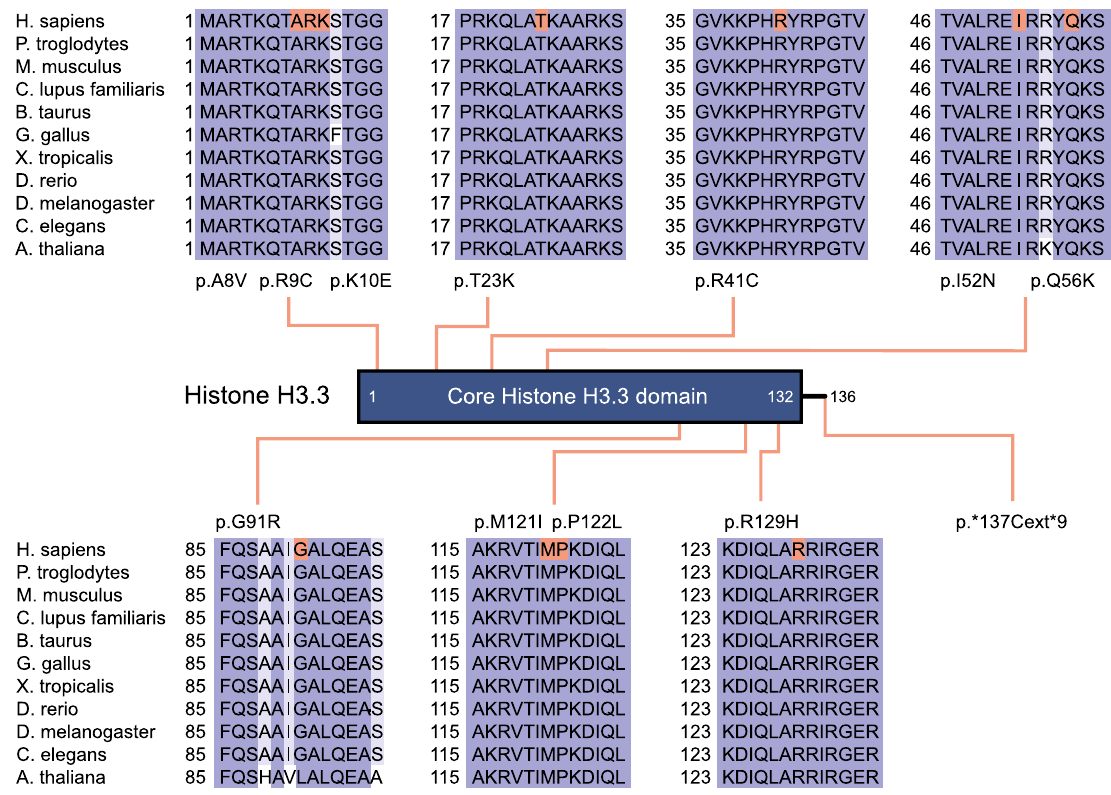
Fig. 1 A two-dimensional schematic representation of histone H3.3. The main functional domain is shown with lines indicating the positions of variants. Protein sequence alignments of histone H3.3 with its orthologs are